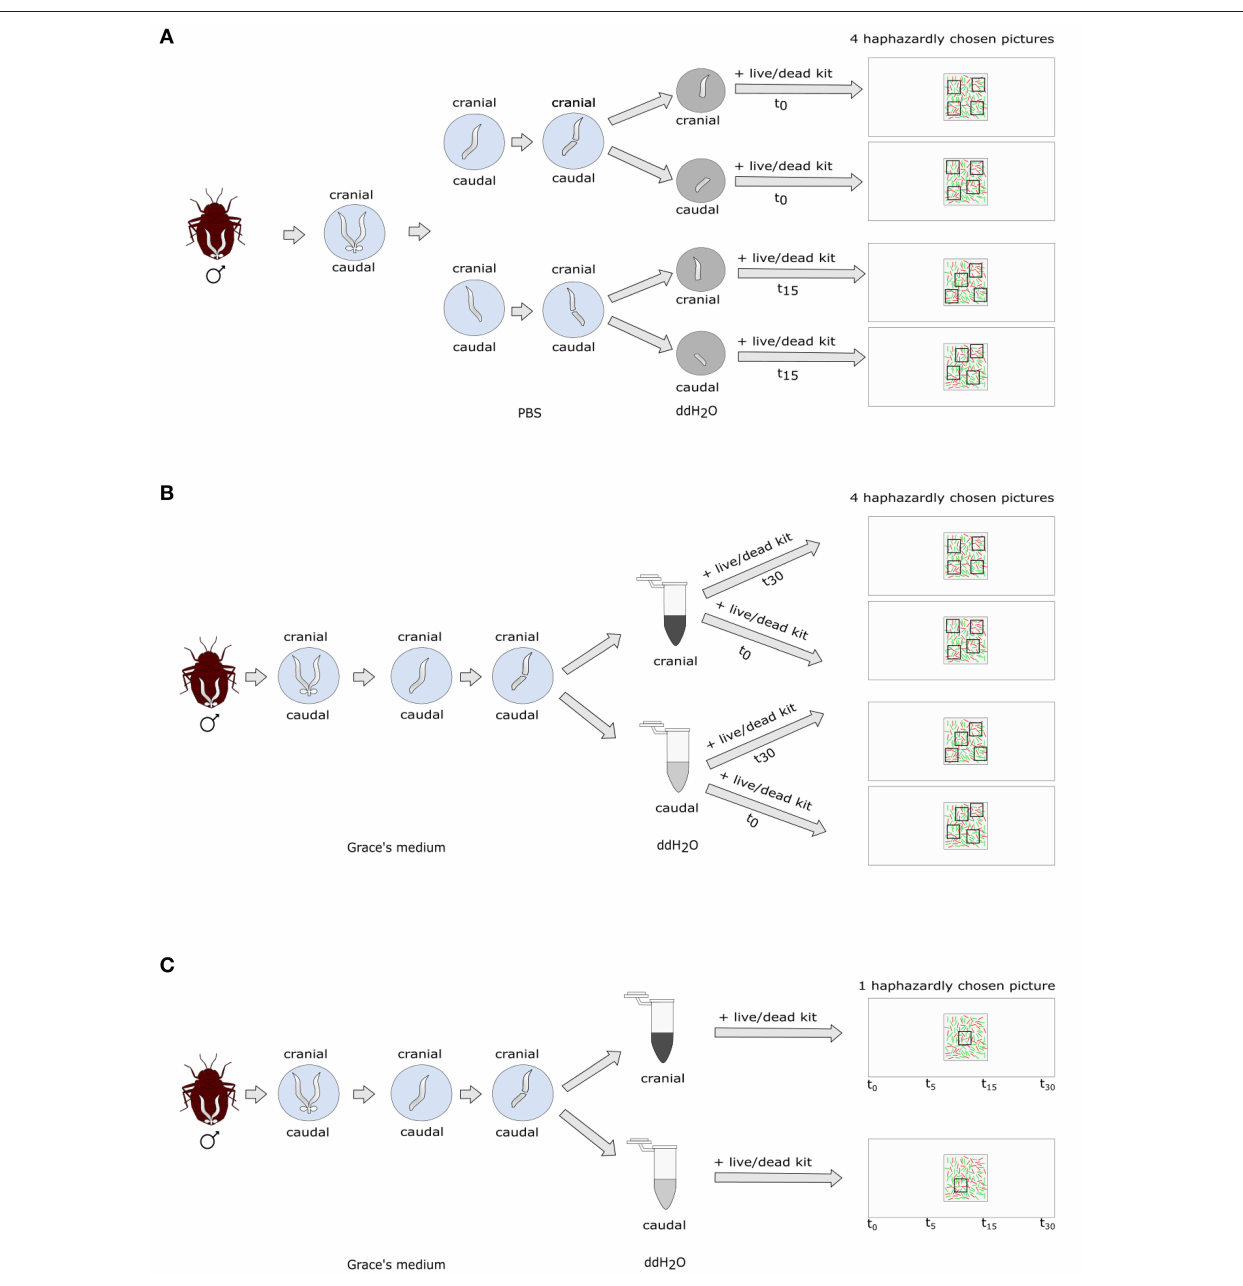
SV (t 30 ). The pictures were taken by a co-worker unaware of the t 0 or t 30